Question: What style of plot is this figure drawn as?
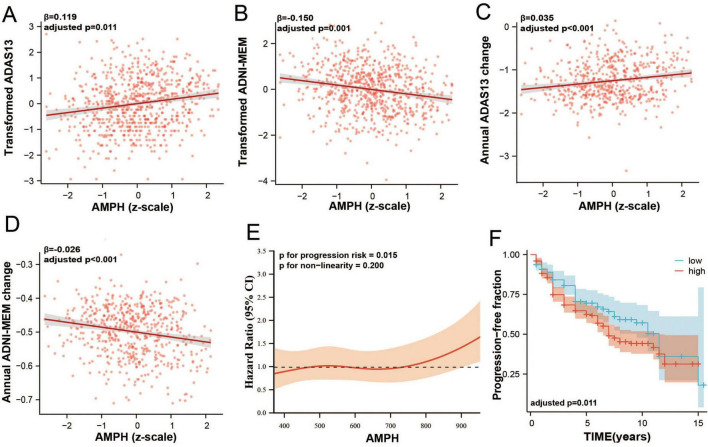
Answer: survival